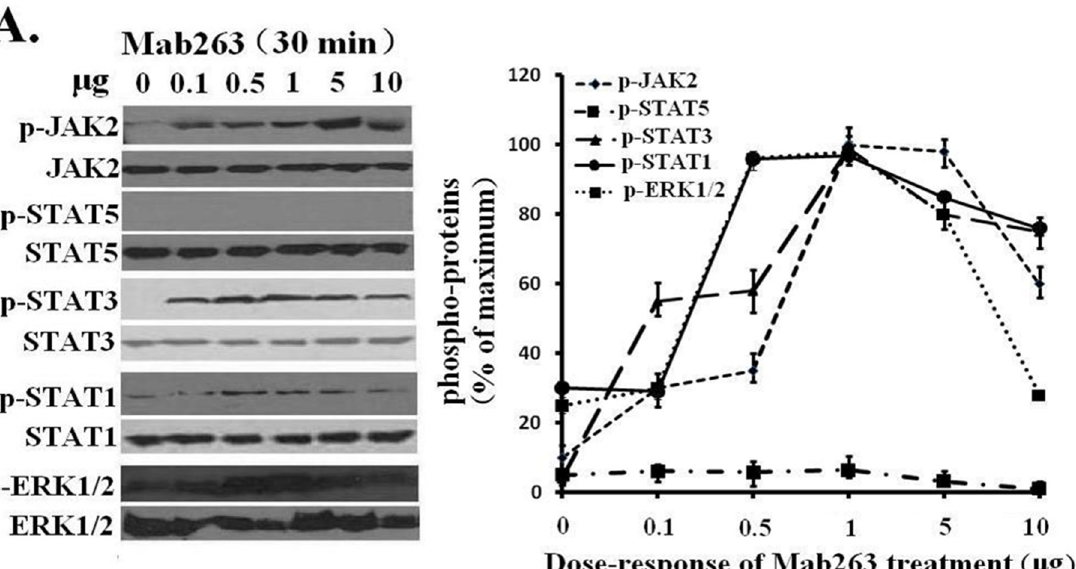
Figure 3. Dose-response and time-course profiles for intracellular signaling proteins activated by Mab263 in the rat GHR cell model. ( A ) Dose response for tyrosine phosphorylation of JAK2, STAT1/3/5 and ERK1/2 induced by Mab263 in CHO-GHR638 cells. The cells were cultured in serum-free medium overnight and incubated with increasing concentrations of Mab263 (0 to 10 μ g/mL) for 30 min at 37 °C. After discarding these liquids, the cell layer was quickly washed three times with ice-cold PBS. The cells were then lysed and collected as described in the Materials and Methods. The samples were then subjected to SDS-PAGE, transferred to PVDF membranes, and western blot analysis was performed with the indicated antibodies. ( Right ) The corresponding histogram of data from three separate western blot